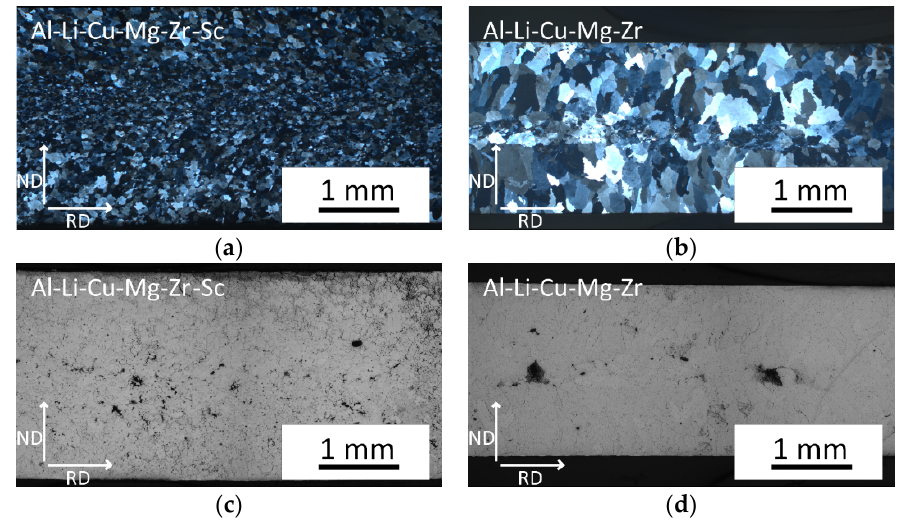
Figure 8. Grain structure ( a , b ) and distribution of eutectic phases ( c , d ) in both alloys after linear heating up to 500 °C and further artificial aging 500 °C/80 min.